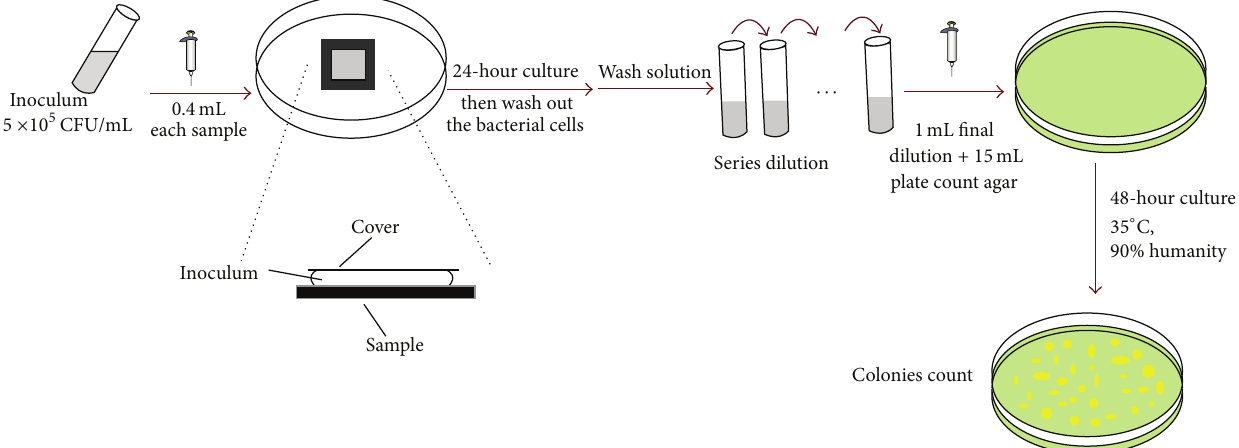
Figure 6: The illustration of Japanese Industry Standard (Z2801) antibacterial test procedures.